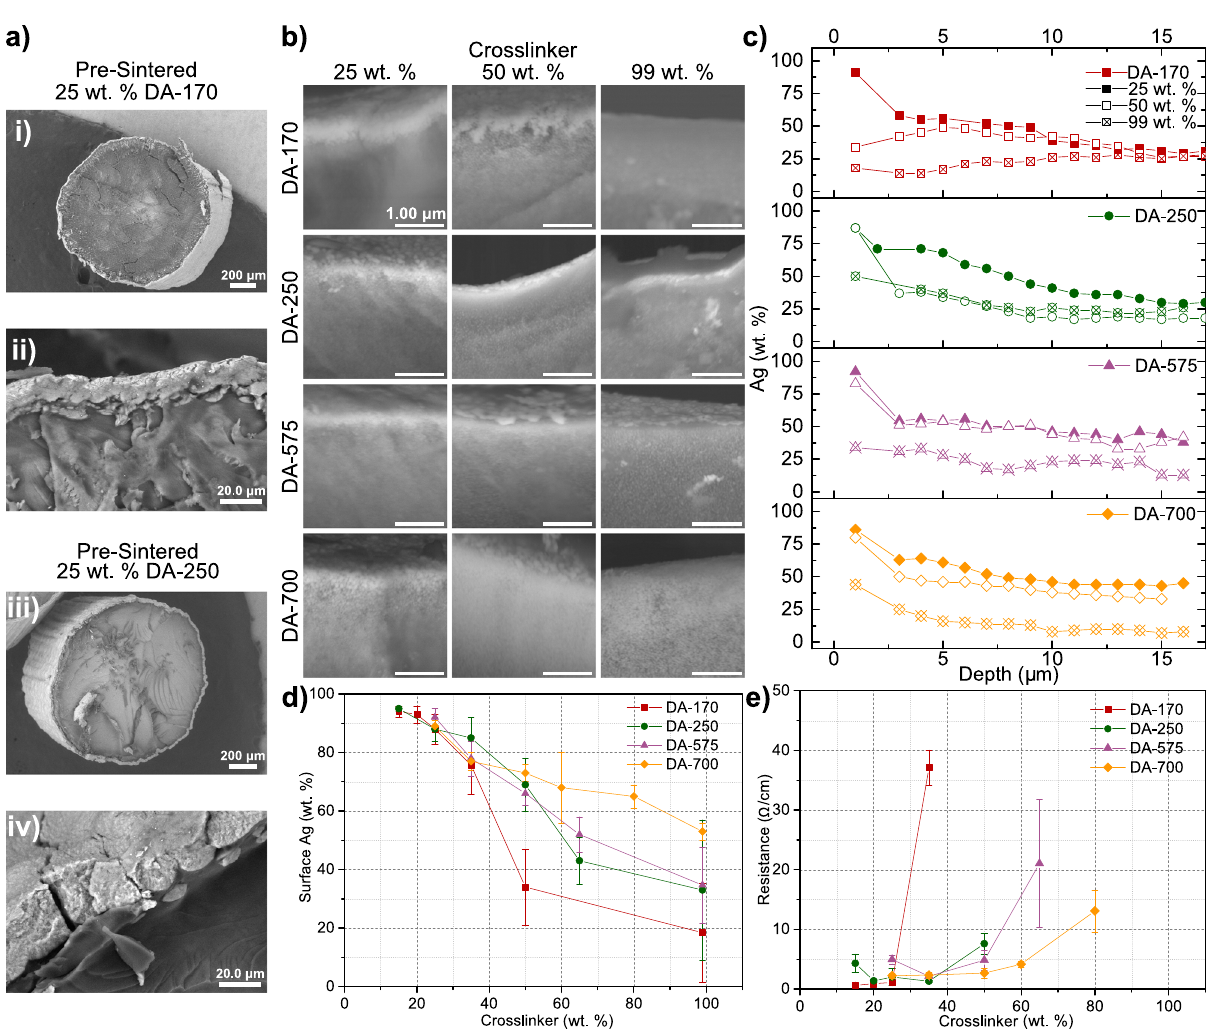
Fig. 2 Silver phase separation as a function of crosslinking density. Cylinders 1.5 mm in diameter and 2 cm in length were printed using resins containing 25 wt. % AgND. a SEM cross-sectional images of cylinders printed using resin mixtures (i, ii) 25 wt. % DA-170 and (iii, iv) 25 wt. % DA-250 and taken prior to thermal sintering, but treated with 5 min of UV curing to convert some of the silver salt to silver metal. These results con fi rm that the silver complex diffuses to the surface during printing and the partitioning of material phases does not happen post-printing. The cylinders once sintered at 210 °C contain 9.5 wt. % Ag. b Cross-sectional SEM images focused approximately <5 µ m from the edge of the cylinder. Cylinders were printed using 25, 50 and 99 wt. % for DA-170, DA-250, DA-575, and DA-700 crosslinkers. c Weight fraction of silver as a function of depth with respect to the surface as measured by performing EDS on the surface of the object (data point at 1 μ m) and on the cross-sections of the cylinders for 25, 50, and 99 wt. % crosslinker of each DA type. d Surface silver of sintered cylinders as a function of wt. % crosslinker as measured by EDS analysis on the surface of the object. The estimated interaction volume of the EDS beam for these measurements performed on the top surface of the object is ~2 µ m. e Resistance as a function of wt. % crosslinker for post-sintered